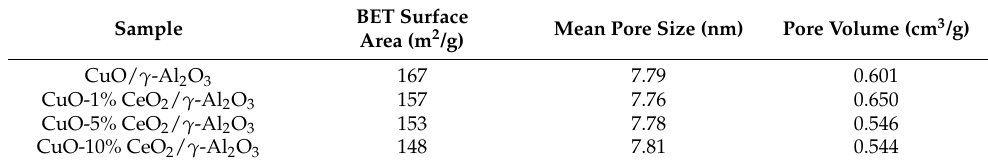
Table 2. Specific surface area and pore structure data of CuO/ γ -Al 2 O 3 and CuO-CeO 2 / γ -Al 2 O 3 .